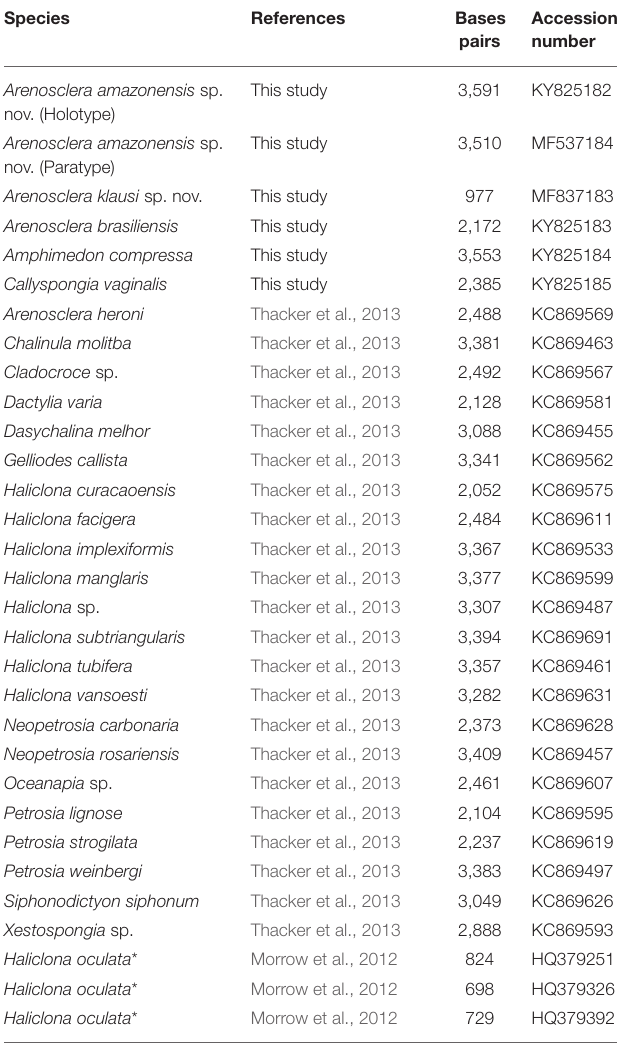
TABLE 2 | List of specimens used in the